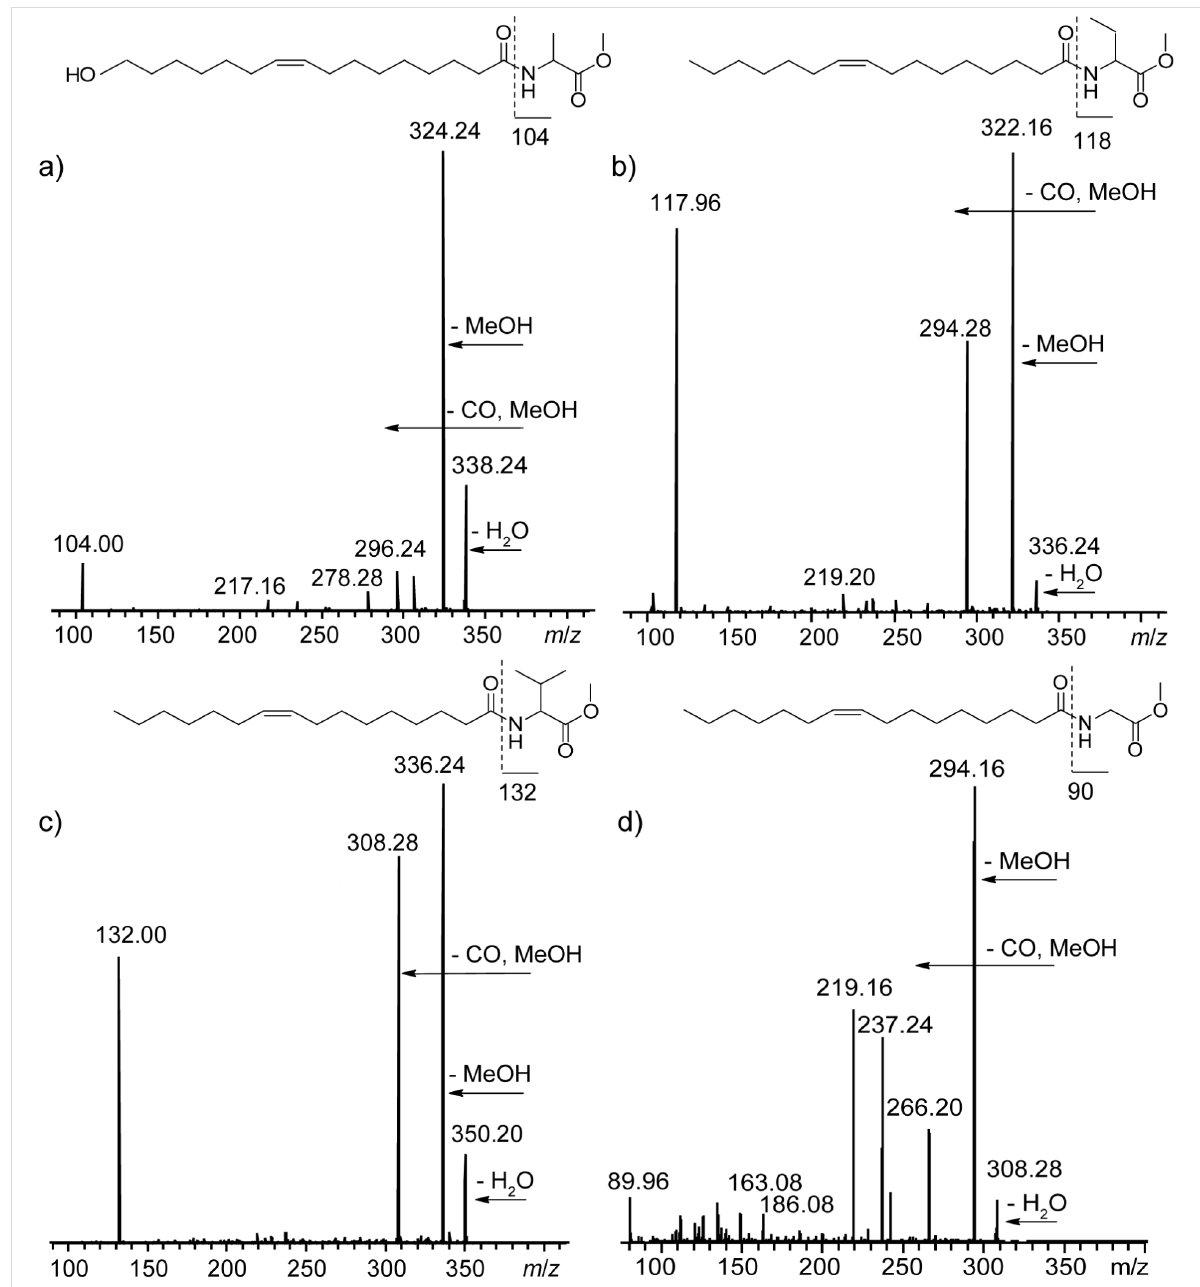
Figure 8: MS 2 spectra in ESI positive mode of a) Z9-16OH-C16:1-NAME with [M + H − H 2 O] + 356, b) Z9-C16:1-NABME ( 8 ) with [M + H] + 354, c) Z9-C16:1-NAVME ( 9 ) with [M + H] + 368, and d) Z9-C16:1-NAGME ( 11 ) with [M + H] + 326.